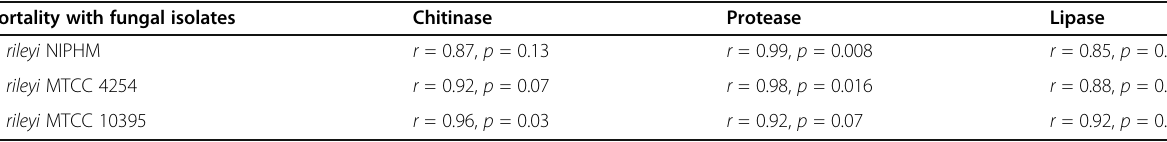
r correlation coefficient, p p